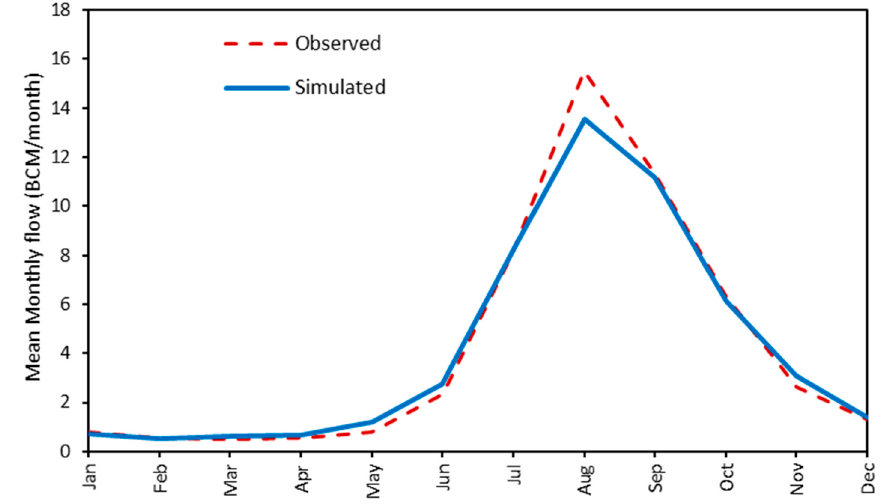
Figure 8. The mean monthly flow at Diem station for the calibrated period.